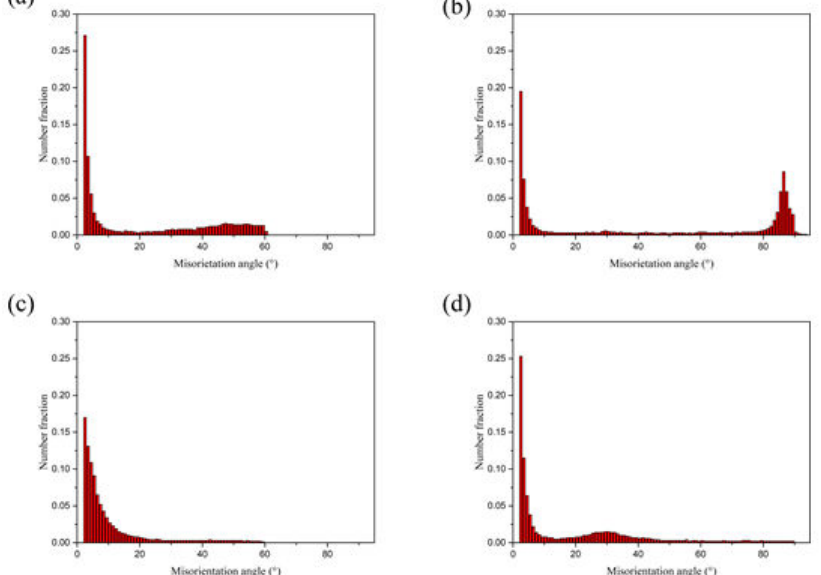
Figure 8. Grain boundary dislocation of Al/Mg composite plate: not rolled: ( a ) Al, ( b ) Mg; The fourth pass: ( c ) Al, ( d )